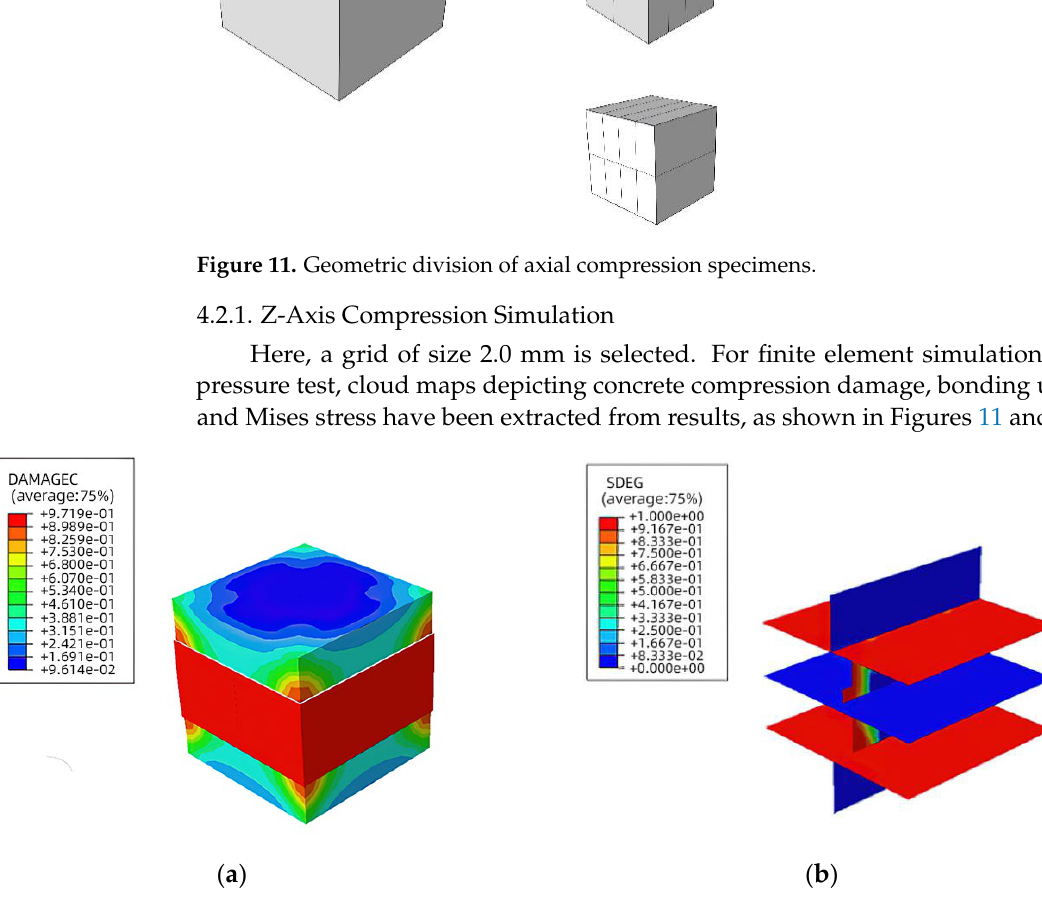
Figure 12. Damage cloud maps of specimen subjected to Z-axis loading compression. ( a ) Concrete compression damage ; ( b ) Adhesive unit damage .